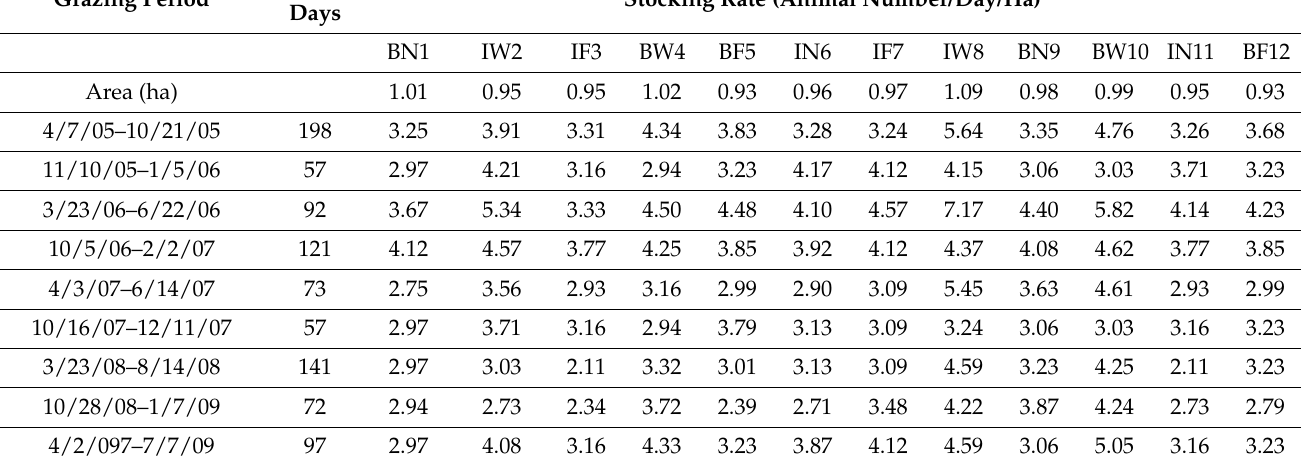
Table 1. Stocking rates for each paddock during the grazing periods. B: Broiler litter; I: Inorganic fertilizer; F: Endophyte free; N: novel–tall fescue MaxQ type with novel endophyte; W: Wild endophyte. Grazing Period